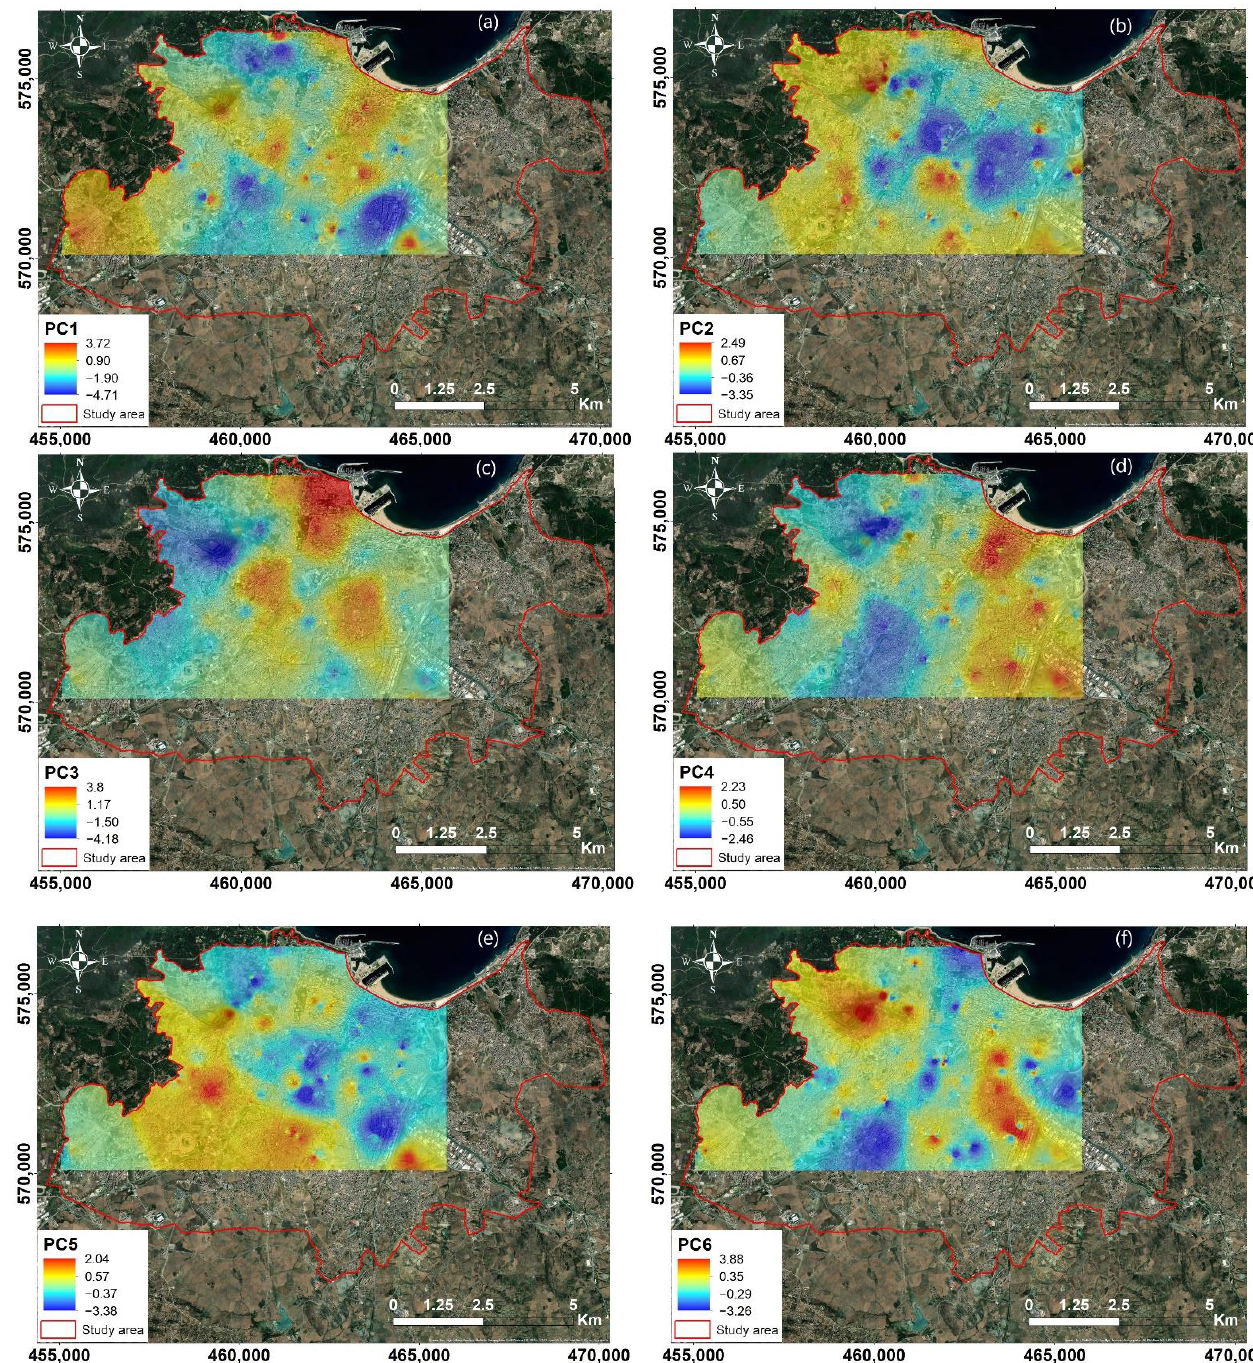
Figure 6. Distribution of the first six principal components (a) PC1, (b) PC2, (c) PC3, (d) PC4, (e) PC5 and (f) PC6 in the part of the city of Tangier covered by the flooding points.